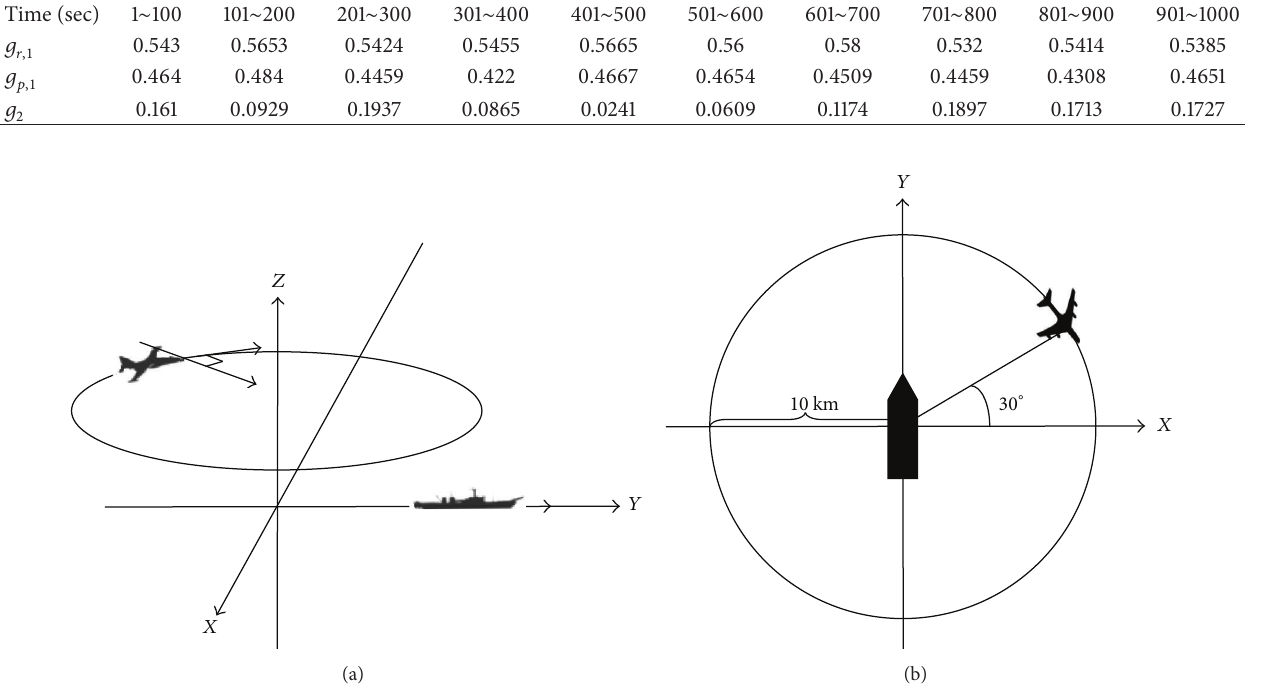
Figure 10: Simulation scenarios of Case 3 for (a) 3D and (b) top view diagrams.